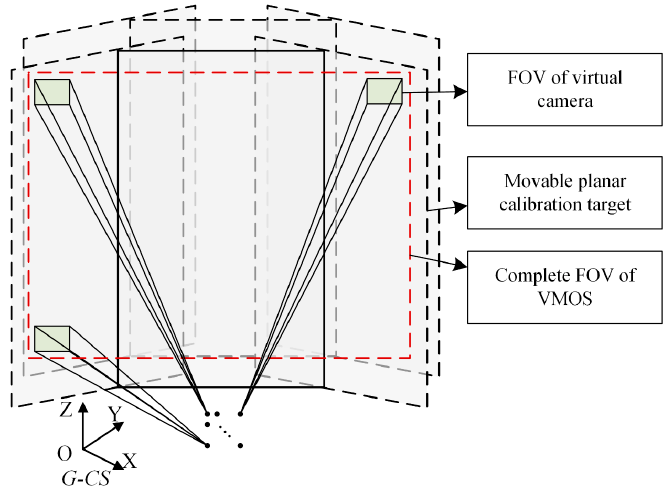
Figure 6. Schematic diagram of the calibration process.